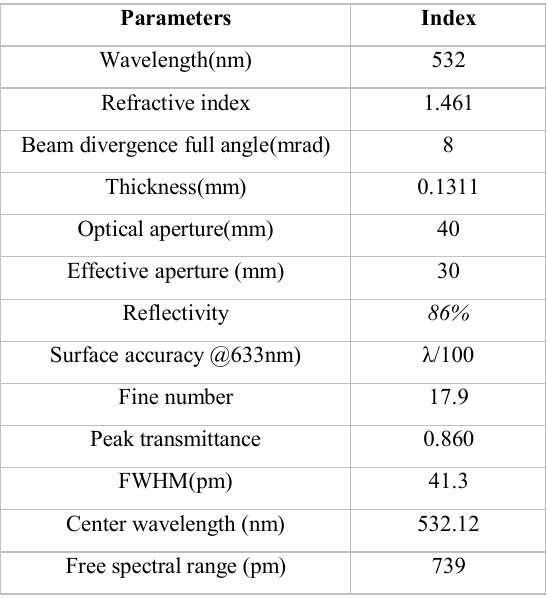
Table 1: Main parameters of FP etalons